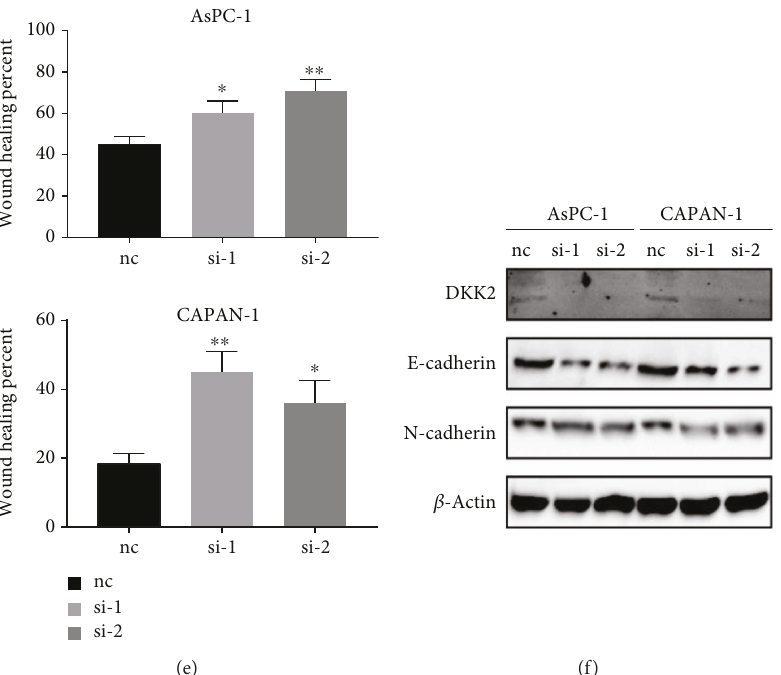
Figure 3: Knockdown of DKK2 promoted tumor cells ’ migration ability. (a) The enrichment plots in DKK2-highly expressed group compared to the low performed by gene set enrichment analysis. (b) Transwell assay showed that silencing DKK2 led to more migrated cells in AsPC-1 and CAPAN-1. For each transwell assay, the cell number was counted (c). (d) Movement of DKK2 knockout and control cells into the wound was shown in AsPC-1 and CAPAN-1 at 0h and 12h. The percentage of wound healing was assessed (e). Signi fi cant di ff erences are indicated as ∗ P < 0 05 and ∗∗ P < 0 001